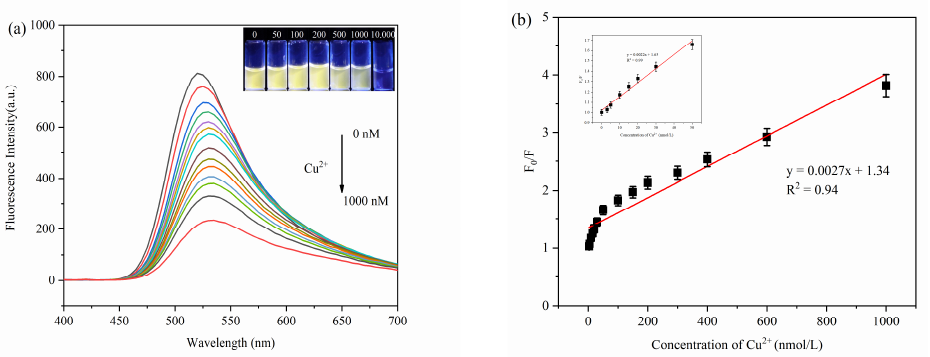
Figure 5. The fluorescence spectra of MPA-InP/ZnS QDs with different added concentrations of Cu 2+ (0 nM, 3 nM, 5 nM, 10 nM, 15 nM, 20 nM, 30 nM, 50 nM, 100 nM, 150 nM, 200 nM, 250 nM, 300 nM, 400 nM, 600 nM, and 1000 nM) ( a ), (insert: photos of MPA-InP/ZnS QDs solutions with different concentrations of Cu 2+ under 365 nm UV light) and the relationship between the F 0 /F and the concentrations of Cu 2+ ( b ), (insert: the relationship between the F 0 /F and low concentrations of Cu 2+ (0–50 nM)). MPA-InP/ZnS QDs: mercaptopropionic acid capped InP/ZnS quantum dots.